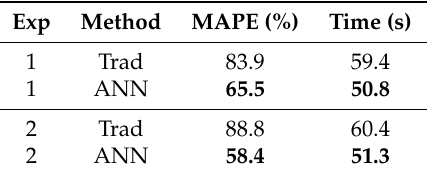
model, (MAPE) the mean values of the distance errors (from D 1 to D 8 ) and (Time) the time to reach the target point. Table 2. Results of three experiments for both